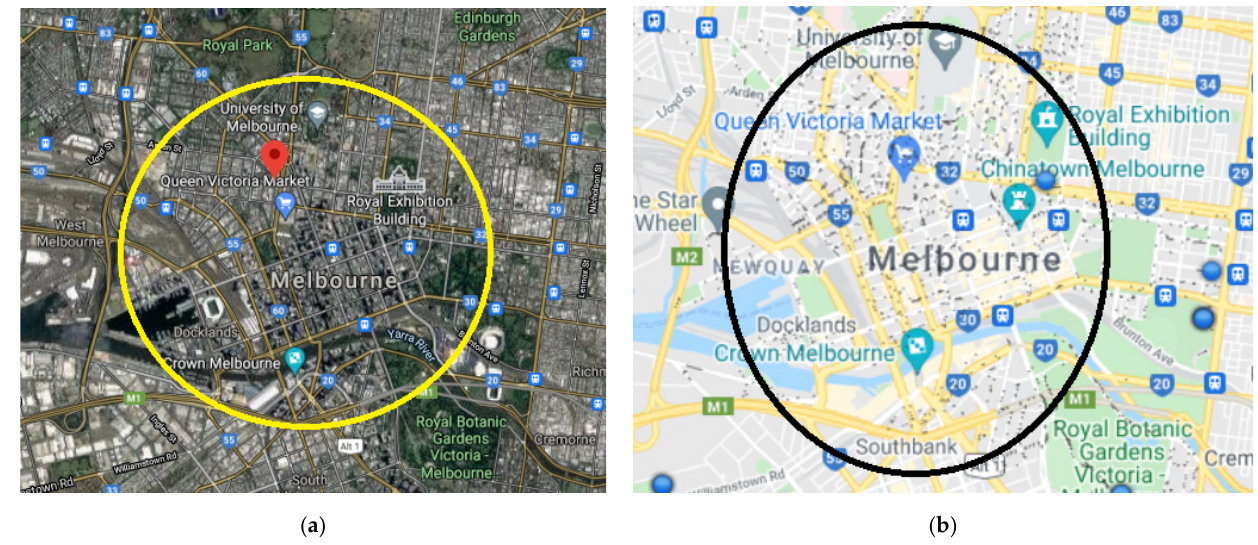
Figure 5. Study area: ( a ) Melbourne CBD, VIC, Australia; ( b ) on-street parking bays. Table 3. Area level comparisons of parking volume in terms of number of vehicles present